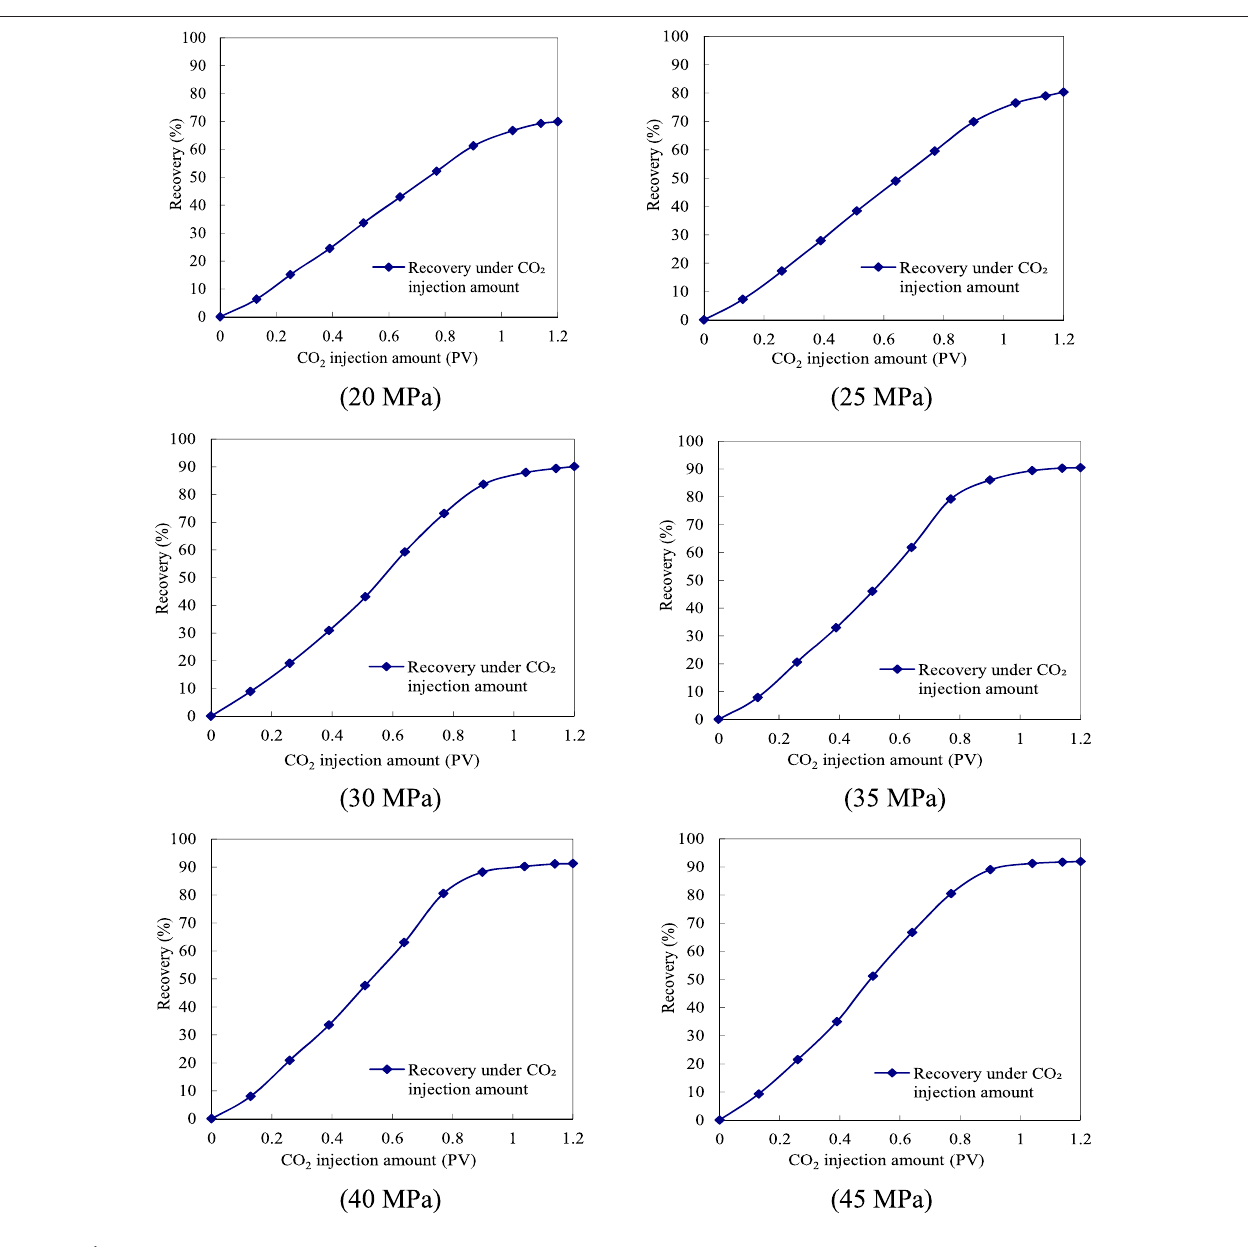
FIGURE 2 | Relationship diagram between recovery ratio and CO 2 injection amount under different pressures.